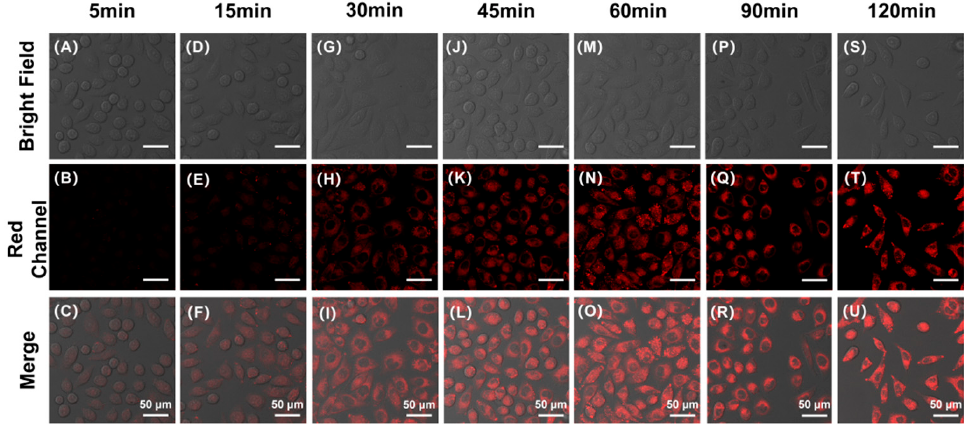
Figure 4. Fluorescent imaging of HeLa cells stained with 10 µ M DBPpys at different incubation times. Incubation times: ( A – C ) 5 min; ( D – F ) 15 min; ( G – I ) 30 min; ( J – L ) 45 min; ( M – O ) 60 min; ( P – R ) 90 min; ( S – U ) 120 min. ( A , D , G , J , M , P , S ) bright field; ( B , E , H , K , N , Q , T ) red channel (650 – 750 nm); ( C , F , I , L , O , R , U ) merge image. λ ex = 550 nm. Scale bar = 50 μ m.